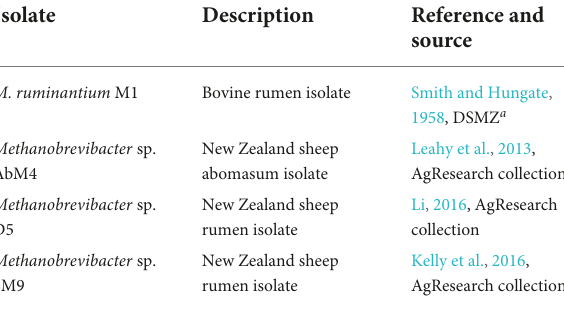
TABLE 1 Methanogen